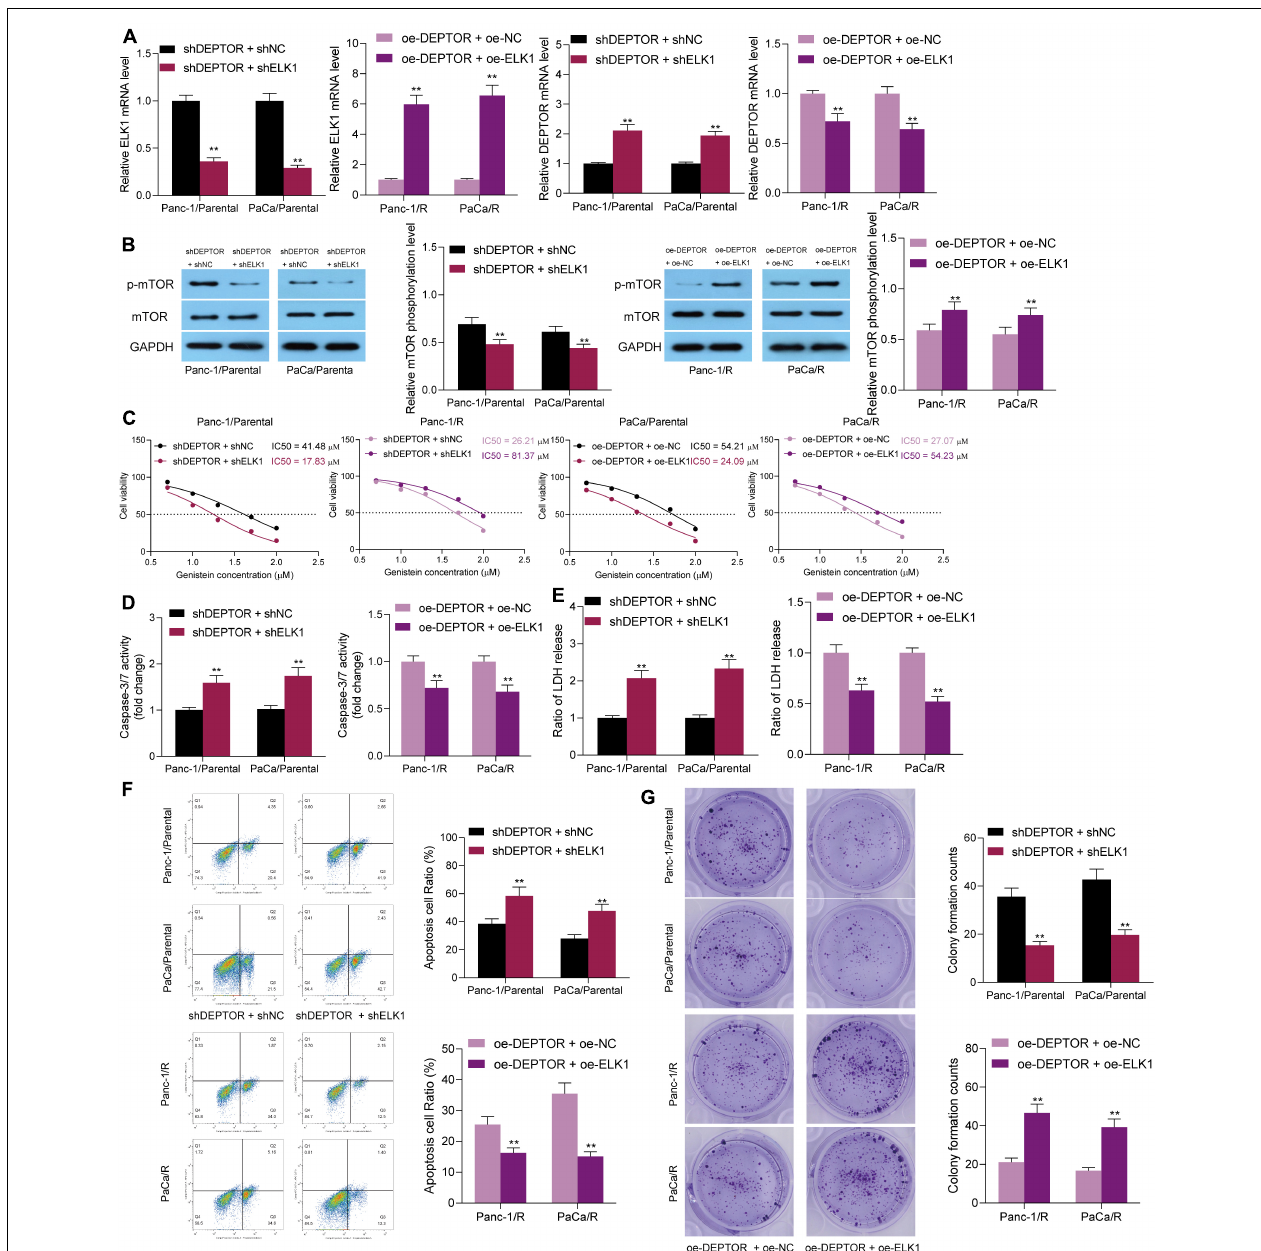
FIGURE 6 | Overexpression of ELK1 reduces sensitivity of PC cells to genistein. (A,B) Protein level of ELK1 and phosphorylation of mTOR in genistein-resistant and parental cells examined by Western blot analysis. (C) IC50 of genistein in PC cells evaluated by a CTG kit. (D) Activity of caspase-3/7 in cells examined by a caspase-3 kit. (E) Lactate dehydrogenase (LDH) release in cells measured using an LDH release kit; (F) Apoptosis rate in PC cells assessed using flow cytometry. (G) Viability of cells evaluated using the colony formation assay. Data were collected from three independent experiments and presented as mean ± SD. ** p <